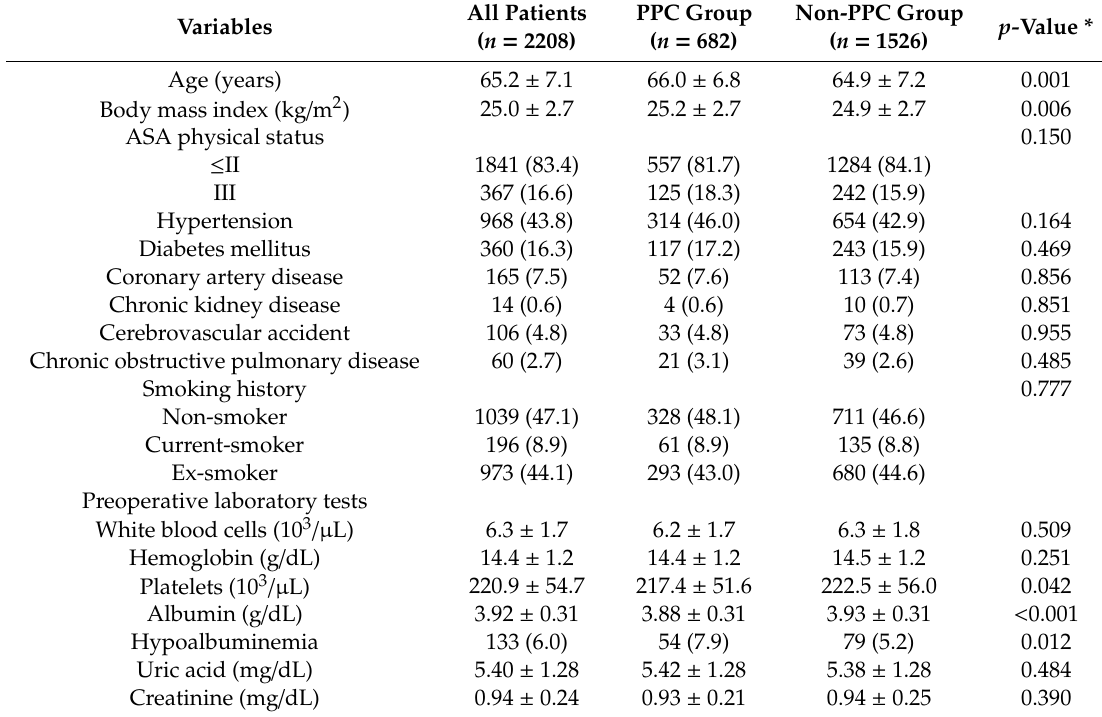
Table 1. Demographic and clinical